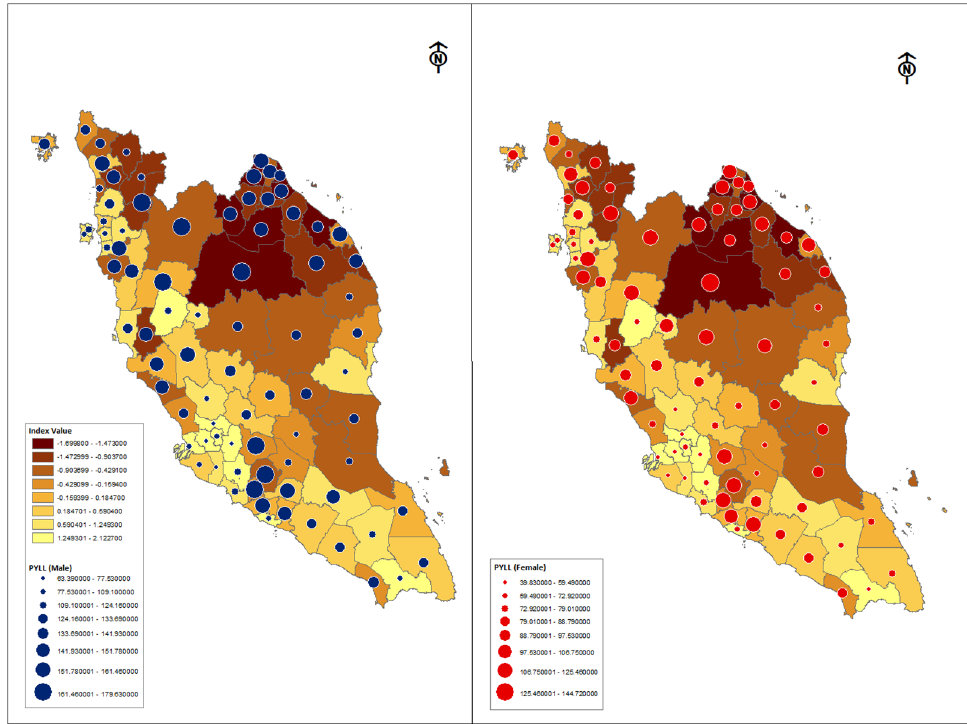
Fig 1. Geographical distribution of the Socioeconomic Index and Potential Years of Life Lost (PYLL) for males and females in Peninsular Malaysia. Yellow areas represent high socioeconomic advantage and dark brown areas, low socioeconomic advantage. The size of the blue and red circles represents the extent of premature mortality among males and females respectively. As values for PYLL differ for both genders, different ranges are used for both; therefore comparisons are for between males or females geographically and not for between males and females.